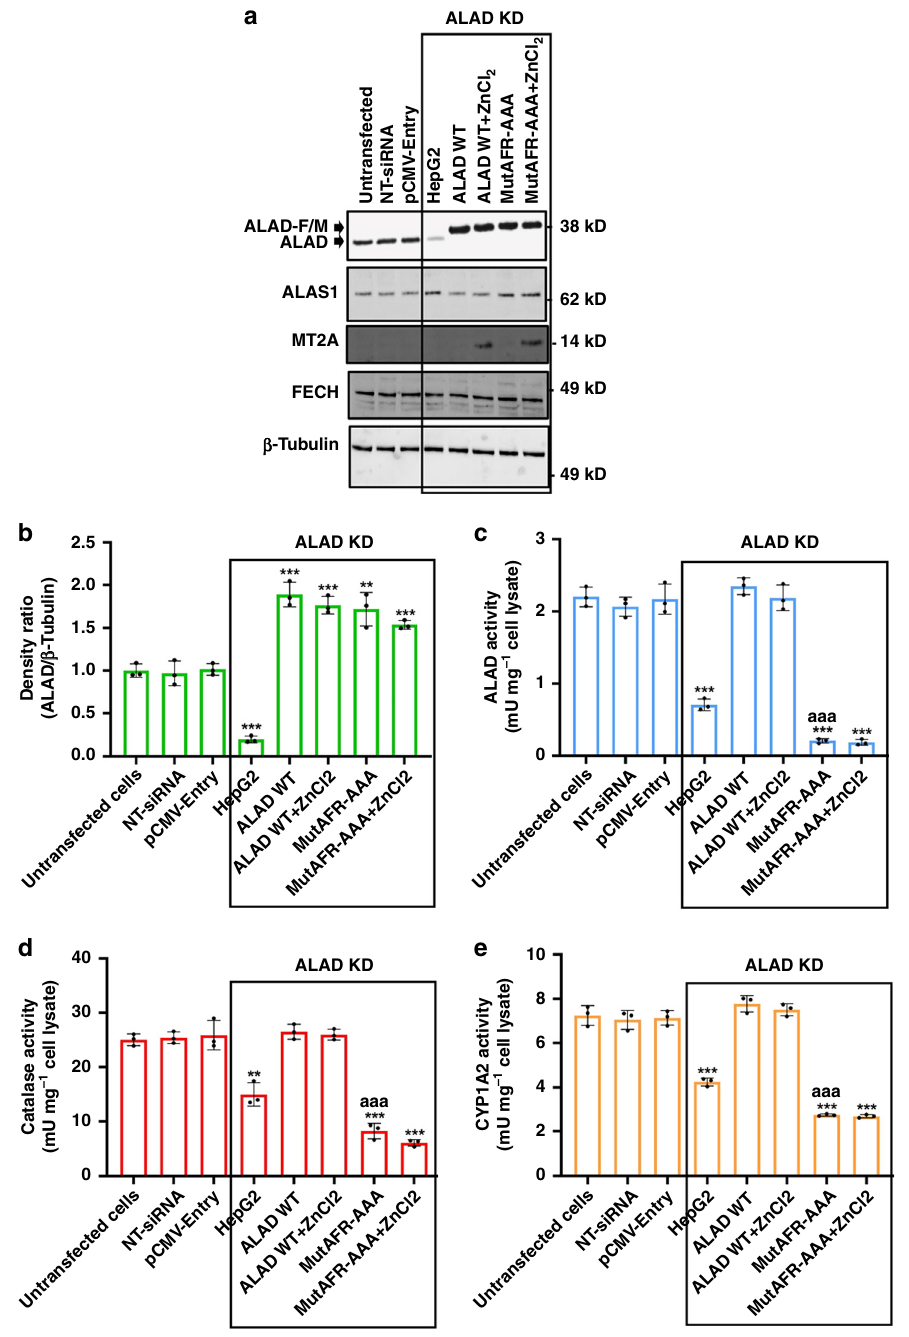
Fig. 3 The [Fe 4 S 4 ] cluster is important for ALAD activity in HepG2 cells. a Western blot analysis of protein levels of endogenous and exogenous ALAD, ALAS1, MT2A, and FECH in untransfected HepG2 cells, HepG2 cells transfected with nontargeting siRNA (NT-siRNA) or pCMV-Entry empty vector (pCMV- Entry), ALAD de fi cient HepG2 cells (ALAD KD), HepG2 cells from the ALAD WT and Mut AFR-AAA groups without or with 100 μ M ZnCl 2 addition (ALAD WT, ALAD WT + ZnCl 2 , Mut AFR-AAA or Mut AFR-AAA + ZnCl 2 , respectively). The experiments were repeated at least twice independently with similar results. b Densitometry of the ratios between the intensities of ALAD and the corresponding β -Tubulin protein levels. c ALAD, d catalase, and e CYP1A2 activities in lysates of these cells. The data in panels b , c , d , and e are presented as mean values±standard deviations of n = 3 biologically independent samples. Two-sided unpaired Student ’ s t -test was employed to analyze statistical signi fi cance. No multiple comparison was performed. **, *** represent P <0.01 and P < 0.001, respectively, versus “ untransfected cells ” ; aaa represents P <0.001 versus the “ ALAD WT ” group. The exact P values are provided in the Source Data fi